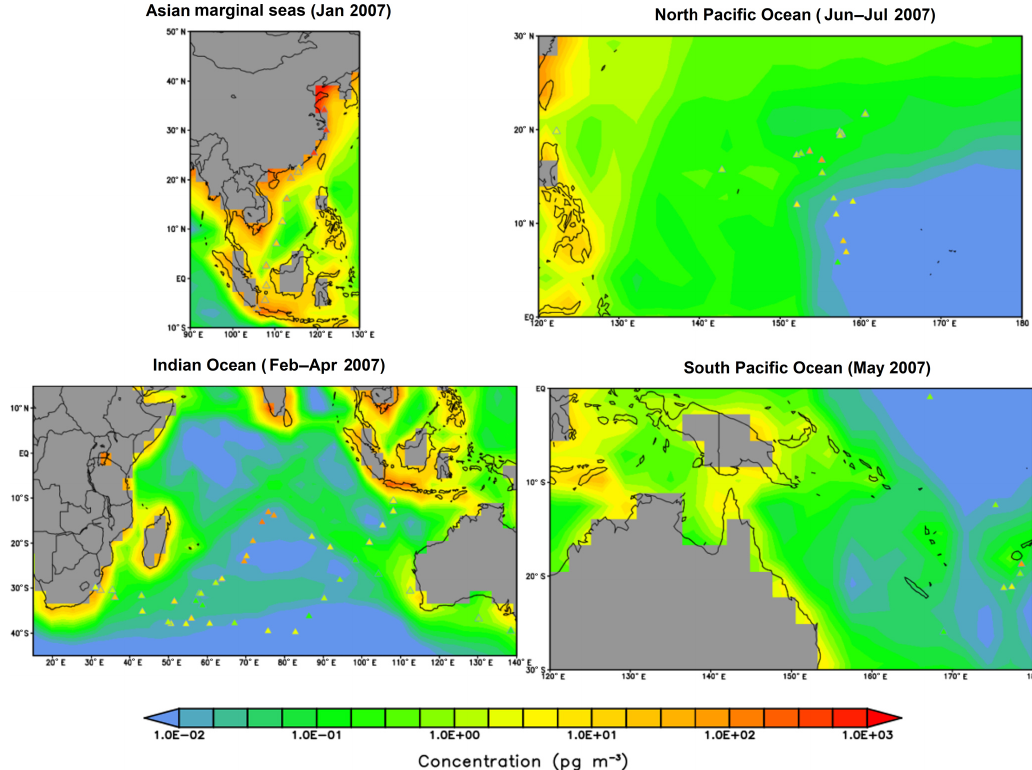
Figure 7. Simulated BaP concentrations (pgm − 3 ) over the four ocean margins overlaid with concentrations from a ship cruise measurement campaign (triangles). Land grid cells are depicted in gray shades.